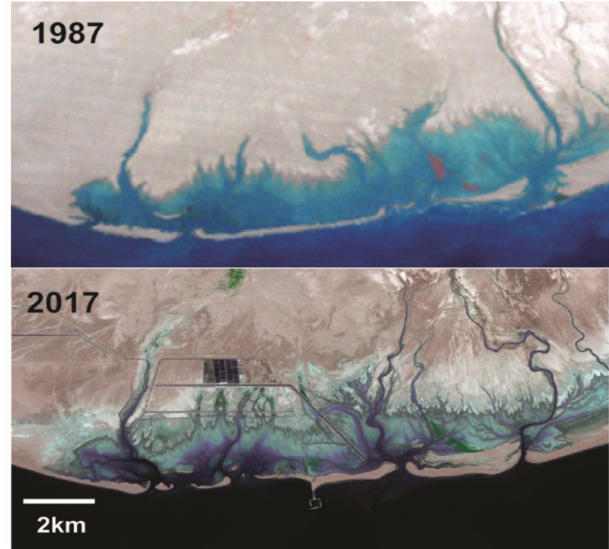
Figure 7. An example of shoreline change as a result of human activity at Gabrik, after construction of a jetty in the middle part of the photo, the sandy barriers on the left side are eroded while sand spits and barriers on the right side have